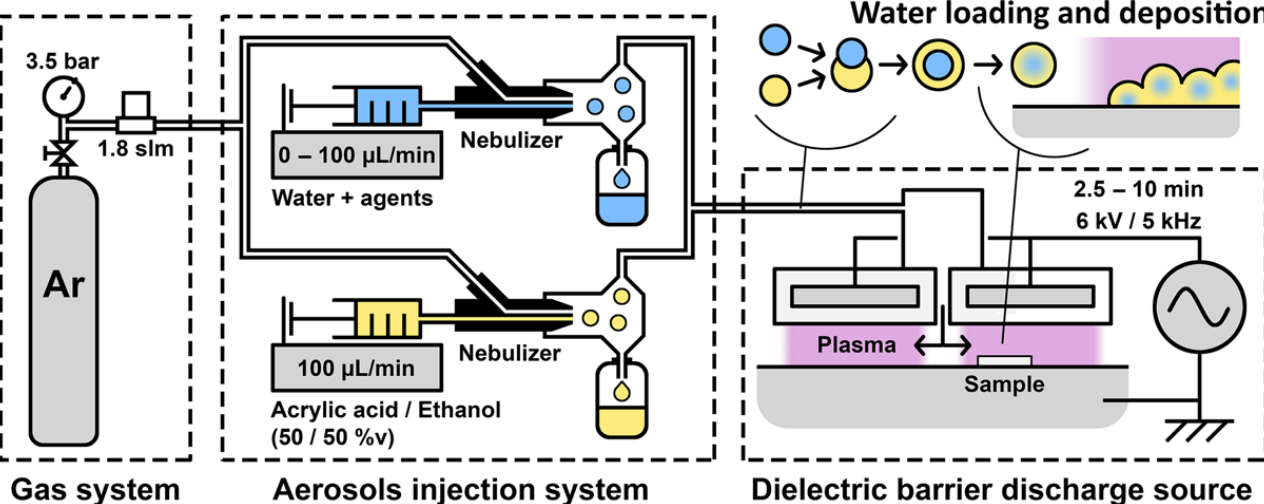
Figure 1. Scheme of the experimental set-up of the open-air aerosol-assisted atmospheric pressure plasma deposition; gas system feeds the aerosols injection system, aerosols are nebulized and mixed in the Ar flow, aerosols are injected into the dielectric barrier discharge to be deposited on silicon wafer samples. Scheme of the in-flight loading of the water droplets into the precursor aerosol, as depicted by the solvent exchange method, and deposition mechanism.